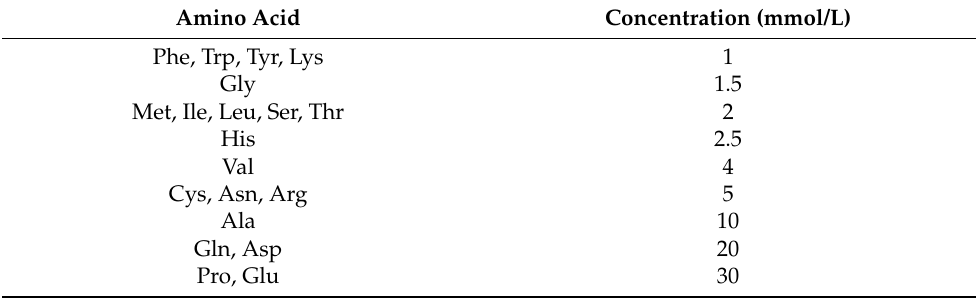
Table 1. Amino acid concentrations in the Murashige and Skoog (MS) medium used in the amino acid affinity experiments of transgenic Arabidopsis thaliana . Amino Acid Concentration (mmol/L) Phe, Trp, Tyr, Lys 1 Gly 1.5 Met, Ile, Leu, Ser, Thr 2 His 2.5 Val 4 Cys, Asn, Arg 5 Ala 10 Gln, Asp 20 Pro, Glu